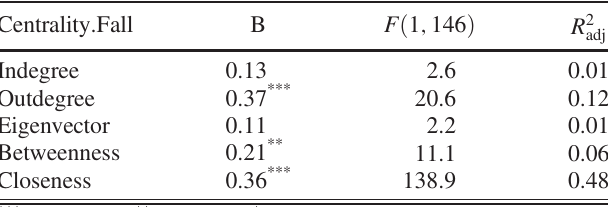
TABLE VIII. Results of the linear regression for centralities at the beginning of Spring semesters as predicted by cor- responding centralities at the end of Fall semesters (centrality.Spring ∼ centrality.Fall). Significant adjusted p val- ues are marked with an